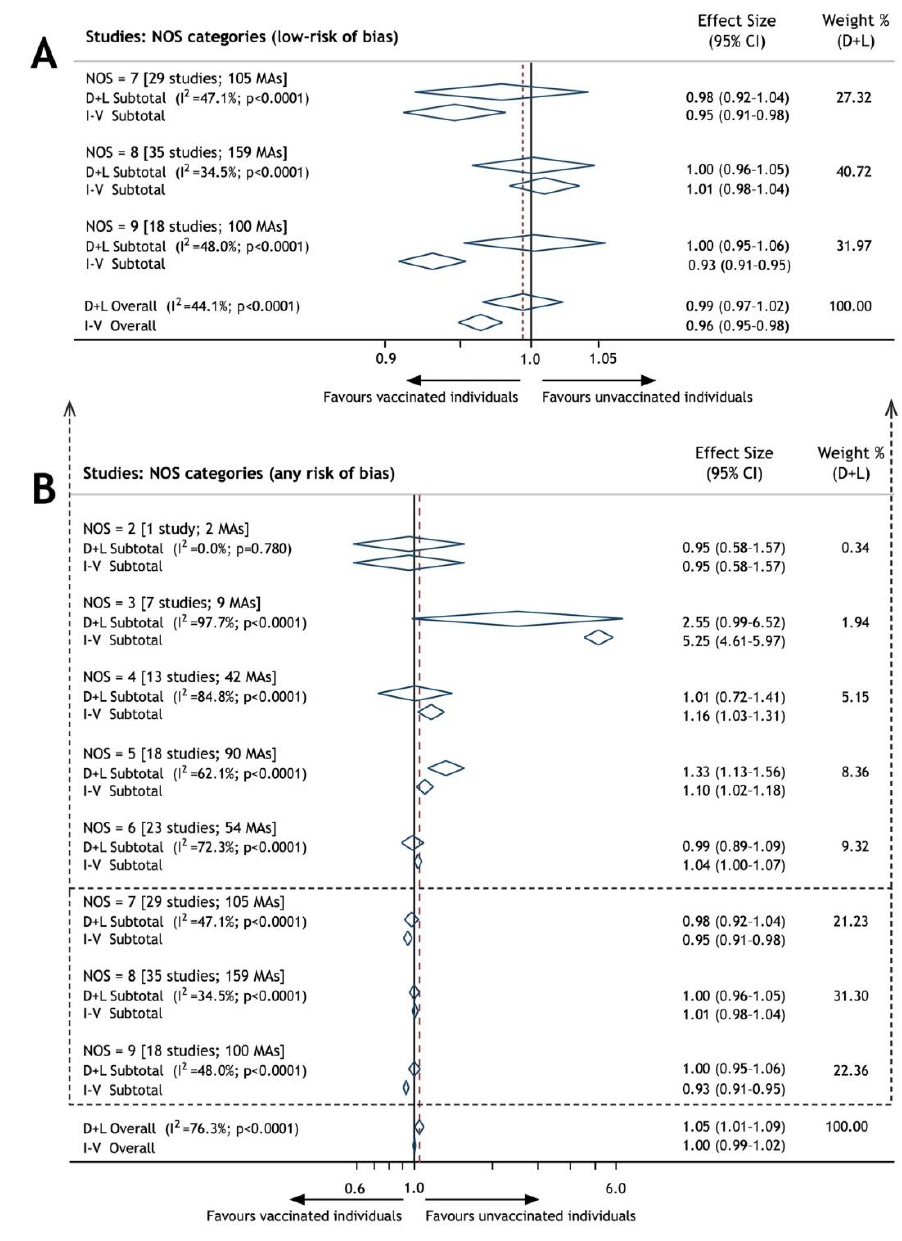
Figure 2. Forest plot of overall and NOS-grouped effect sizes of vaccine-associated autoimmune disorders; weight derived from random effect analysis (dashed line in point of pooled ES); ( A ) any risk of bias risk studies; ( B ) low-risk of bias studies; MAs: measures of association; NOS: Newcastle– Ottawa Scale; I 2 : index of inconsistency; D-L: DerSimonian–Laird method, random-effects model; and I-V: inverse variance method, fixed-effects model. Table 1. Overall and NOS-grouped effect sizes, including parameters of the strength of evidence, robustness, and predic- tion interval.